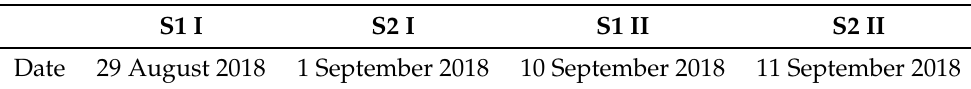
Table 1. The times of the Sentinel-1/Sentinel-2 image pairs.